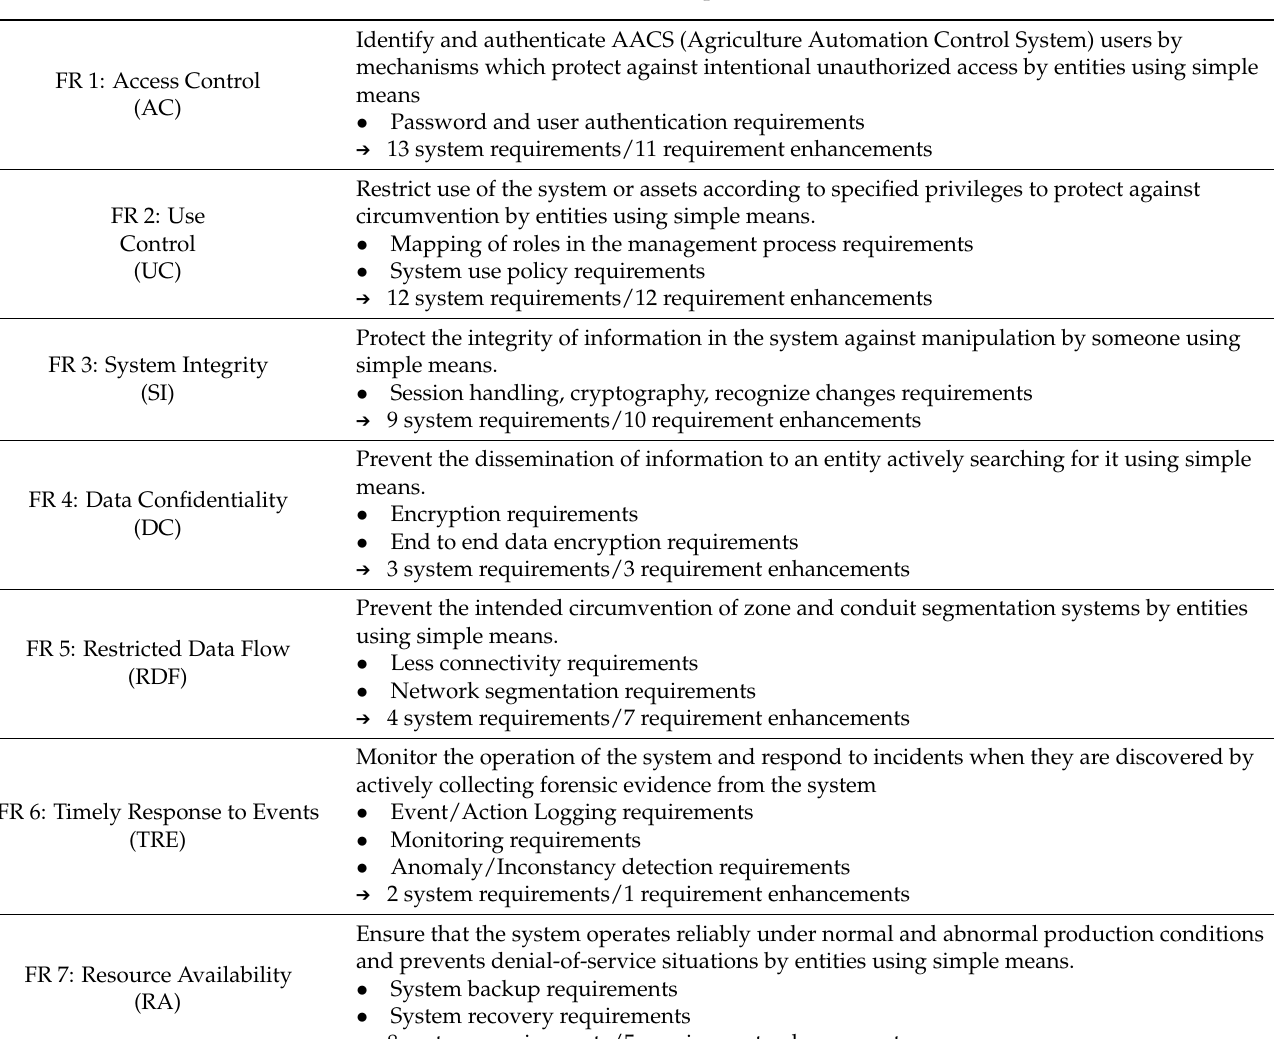
Table 23. Foundational